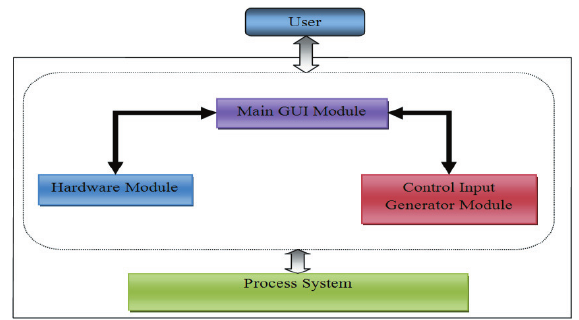
Fig. 1: Generalized Software